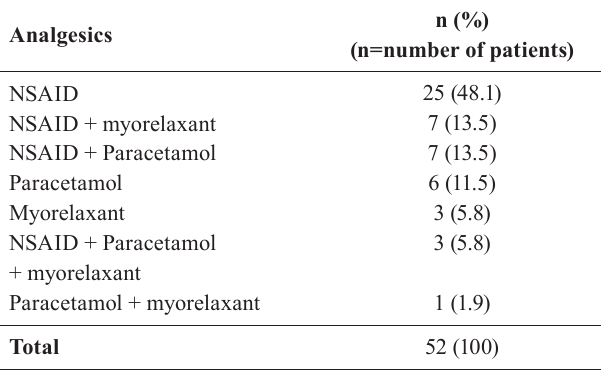
TABLE II - Patients’ self-treatment preferences for analgesics before a doctor visit